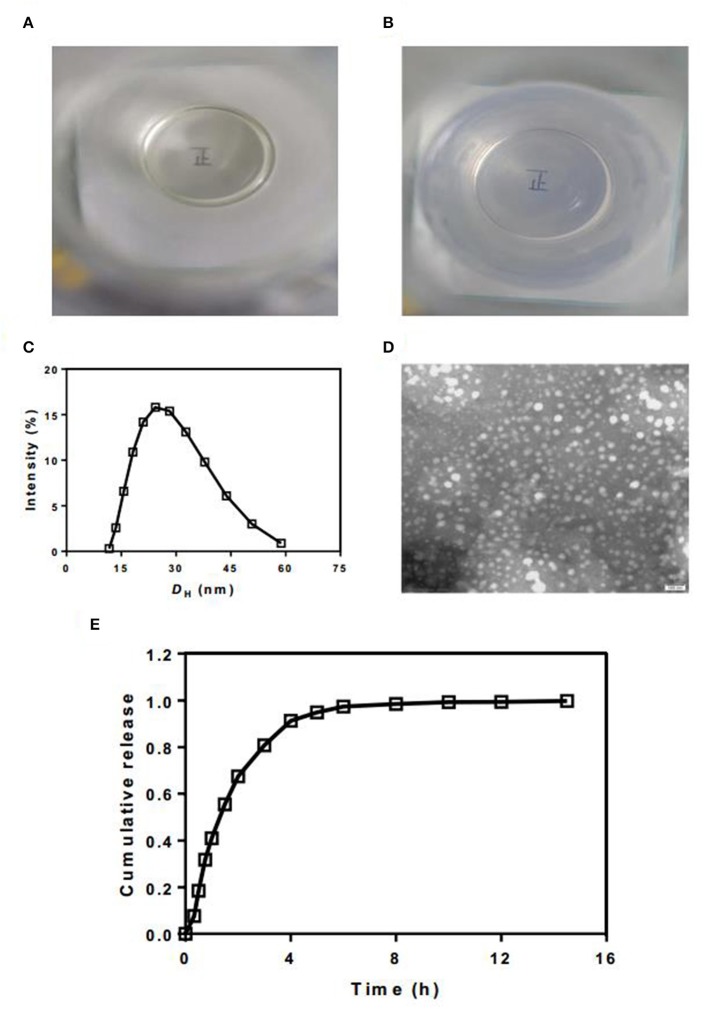
(A,B) The appearance of newly prepared TP-SMEDDS and hydrated TP-SMEDDS; (C) Particle size profile of TP-SMEDDS; (D) Transmission electron microscope photograph of TP-SMEDDS; (E)
In vitro release profiles of TP-SMEDDS. TP-SMEDDS, triptolide-self-microemulsifying drug delivery system.